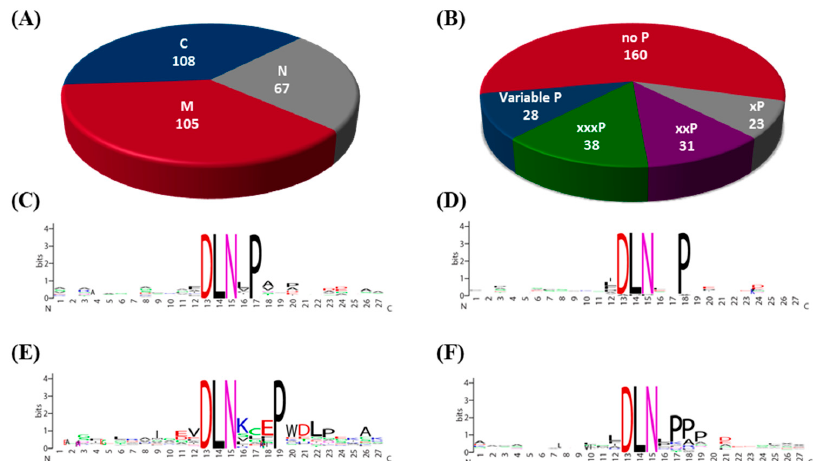
Figure 2. DLN motif analyses. Pie charts showing ( A ) distribution of DLN motifs in different regions of the protein, namely N ‐ terminal (N), middle region (M), and C ‐ terminal ( C ), and ( B ) the numbers of four types of consensus DLN motifs found in rice, with conserved residues, determined by WebLogo, as ( C ) DLNxP, ( D ) DLNxxP, ( E ) DLNxxxP, and ( F ) variable P.